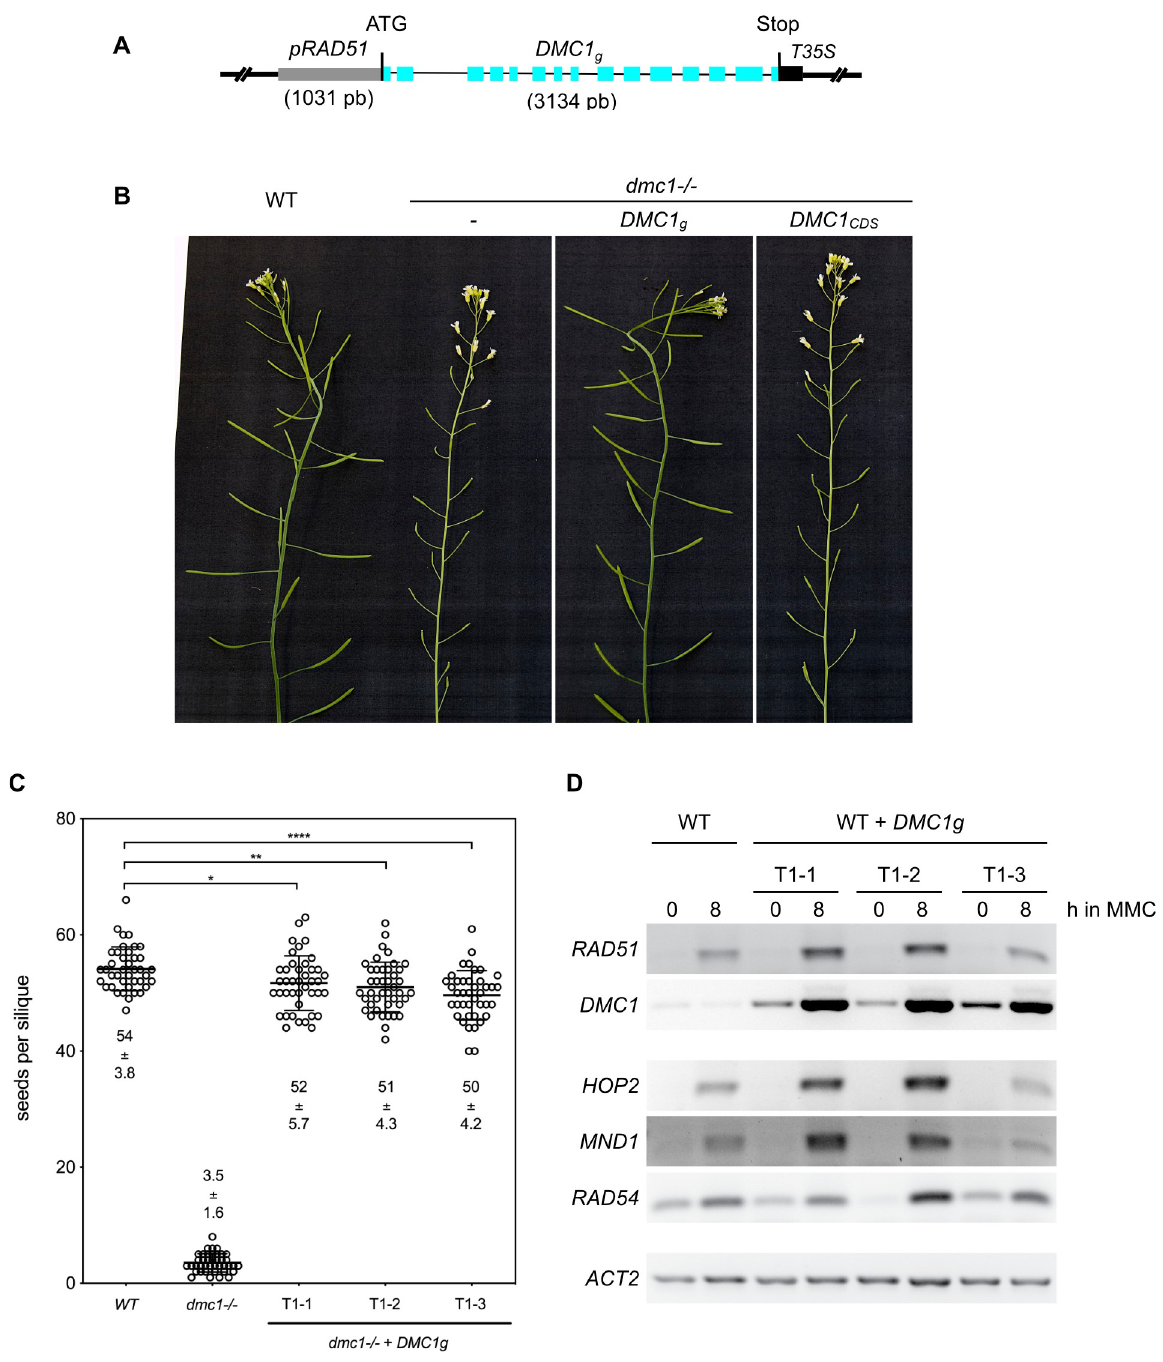
Fig 1. pRAD51 :: DMC1g restores fertility of the Arabidopsis dmc1 mutant and induces expression of DMC1 in somatic cells. (A) Schematic representation of the pRAD51 :: DMC1g construct. DMC1g indicates DMC1 genomic sequence. Exons are shown as blue rectangles. (B) Wild-type plants have long siliques full of seeds (mean ± S.D: 54.1 ± 0.6 seeds per silique), while dmc1 mutants have very low fertility (mean ± S.D: 3.5 ± 0.25 seeds per silique). Expression of the pRAD51 :: DMC1g genomic sequence in dmc1 mutants restores fertility. (C) number of seeds per silique in DMC1, dmc1-/- , and three dmc1-/- + pRAD51 :: DMC1g independent transformants (T1-1, T1-2, and T1-3) showing restored fertility. Mean numbers are indicated ± S.D. n = 4 plants, N = 10 siliques per plant. (D) RT-PCR expression analysis of RAD51 , DMC1 , RAD54 , HOP2 and MND1 in 7-day-old, untreated and MMC-treated (8 h, 20 μ M) seedlings expressing or not the pRAD51 :: DMC1g transgene. Expression was analyzed in wild-type plants and three independent transgenic lines (T1-1, T1-2, and T1-3). Actin is used as a loading control.